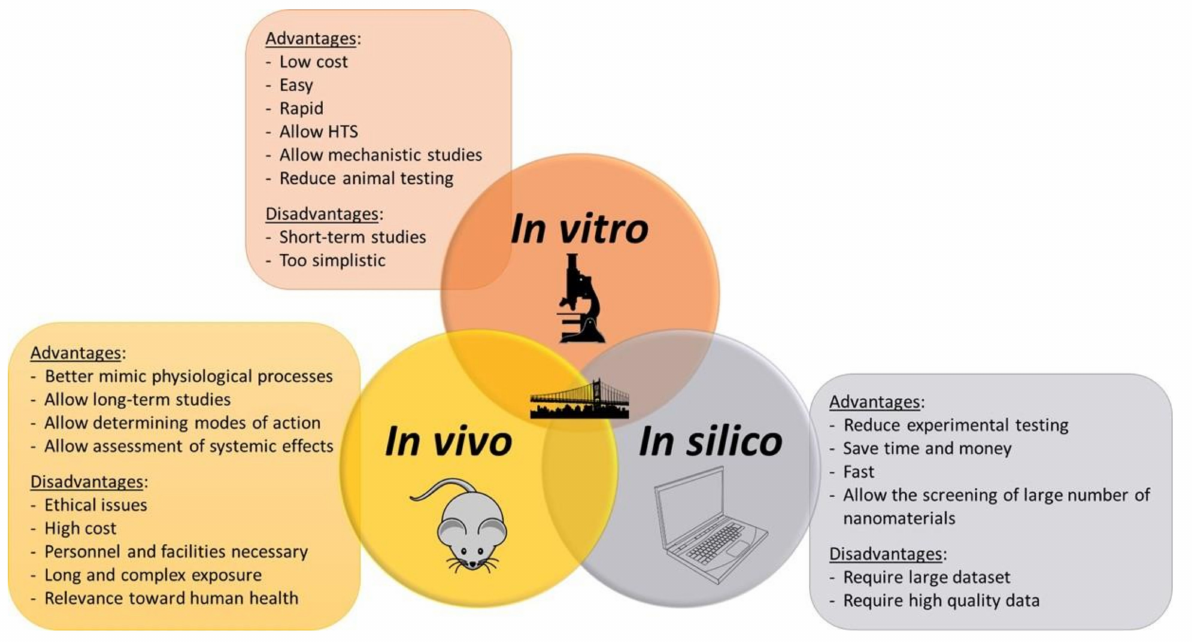
Figure 4. Summary of the advantages and limitations of approaches used in nanotoxicology and perspectives of bridging the gap between these